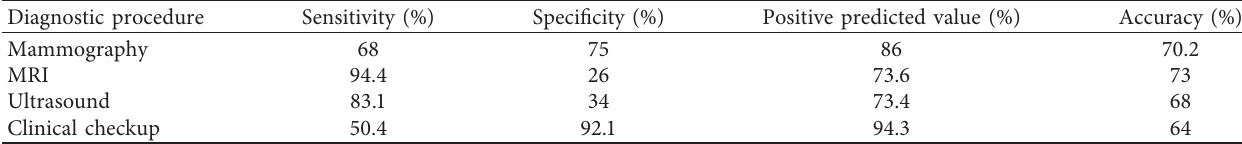
Table 2: Breast cancer detection